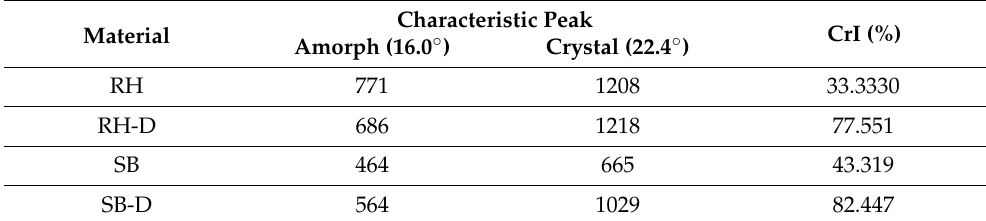
Table 1. Characteristic peaks of rice husk (RH), delignified rice husk (RH-D), sugarcane bagasse (SB), delignified sugarcane bagasse (SB-D).